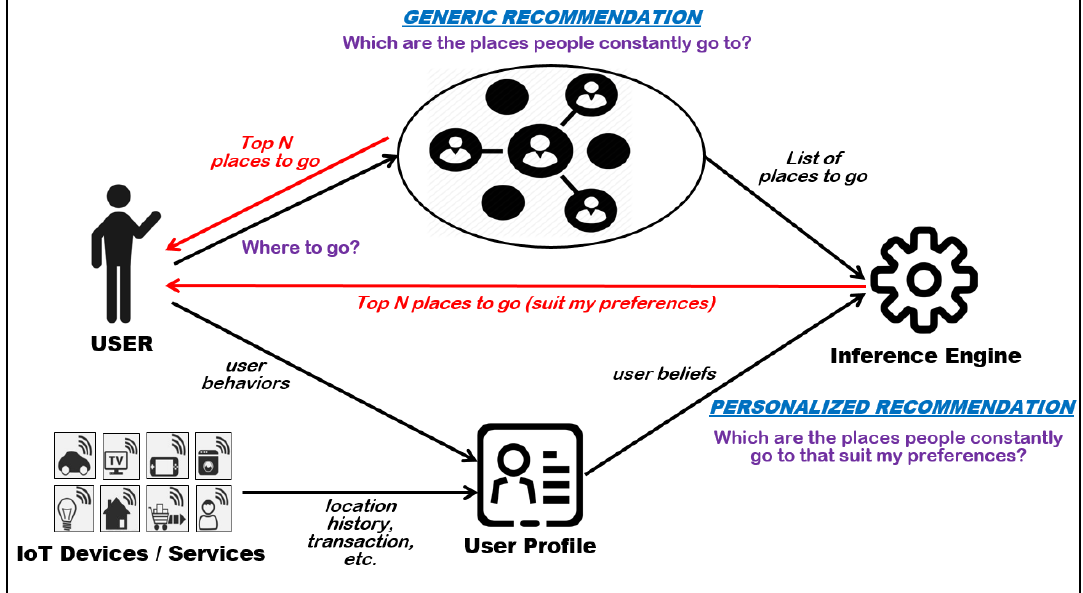
Figure 1. Di ff erences between generic and personalized Figure 1. Differences between generic and personalized recommendations.